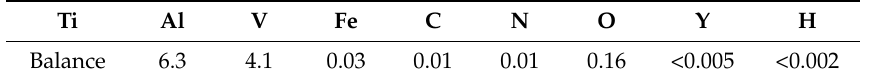
Table 2. Mechanical properties of Ti6Al4V.